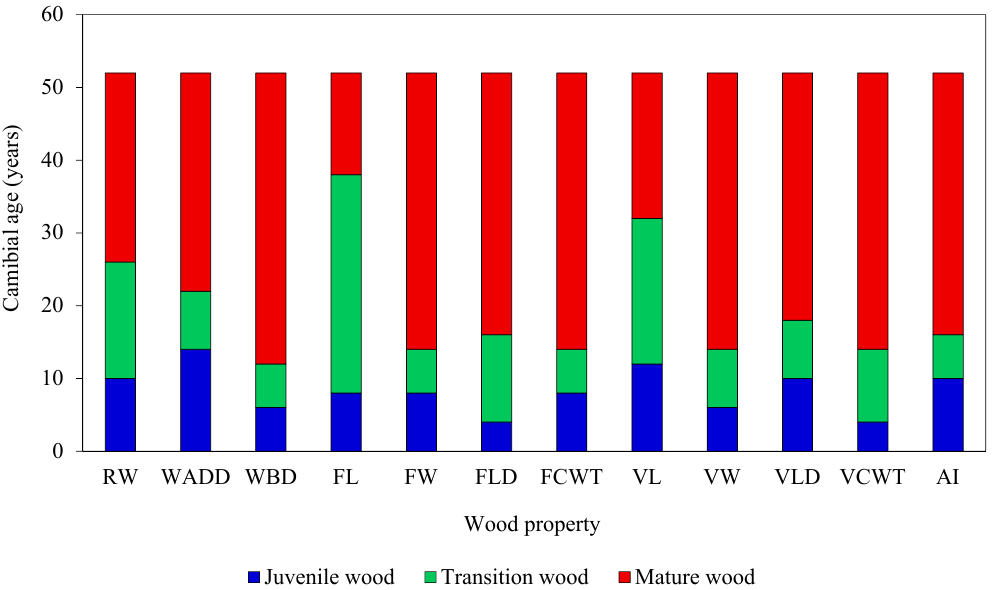
Figure 10. Demarcation of juvenile wood, transition wood and mature wood in S. superba . RW: ring width, WADD: wood air-dry density, WBD: wood basic density, FL: fiber length, FW: fiber width, FLD: fiber lumen diameter, FCWT: fiber cell wall thickness, VL: vessel length, VW: vessel width, VLD: vessel lumen diameter, VCWT: vessel cell wall thickness, AI: aggregative indicator.